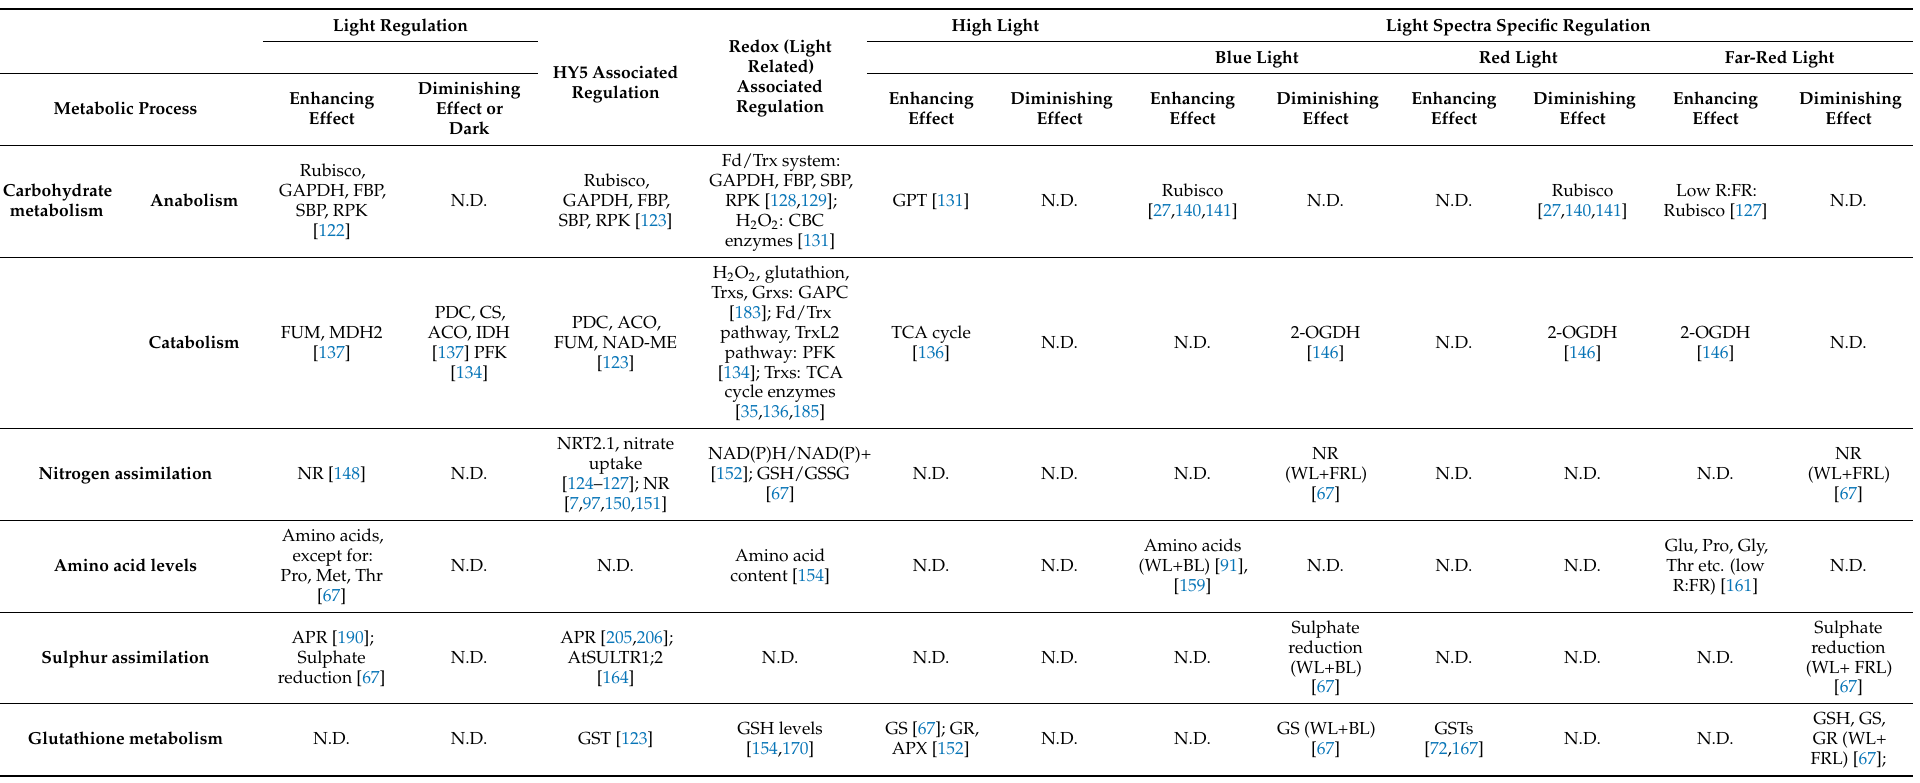
Table A1. Light- and/or redox-associated regulation of key enzymes or metabolites of the important metabolic processes. Light Regulation Redox (Light Related) Red HY5 Associated Regulation